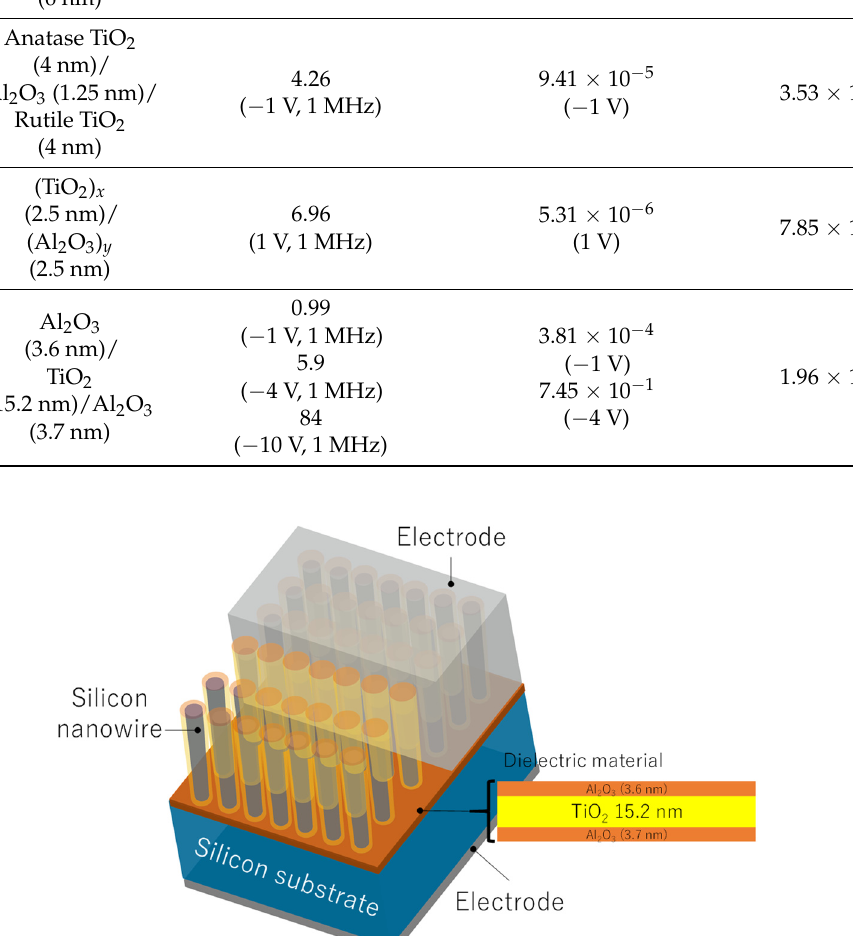
Table 1. Comparison of capacitance density and leakage current density of each capacitor with the literature. 3D structures such as ZnO nanorod (ZnO-NR), porous Si (P-Si), Si trench (Si-TR), anodic aluminum oxide (AAO), and SiNW were used as a template. Part of the data was read from the figure in each reference using a software.